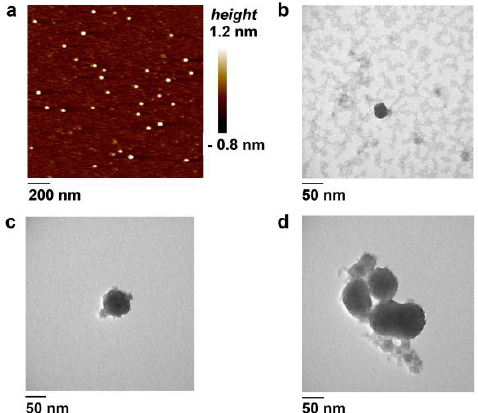
Figure 3. Characterization of D-17 ( a , b ) and D-17 PG ( c , d ) micelles in TAM buffer by atomic force (AFM) ( a ) and transmission electron (TEM) ( b – d ), contrasting using uranyl acetate) microscopies. Scale bars are indicated. Each sample contained 1.5 µM (AFM) or 5 µM (TEM) of the corresponding oligomer.